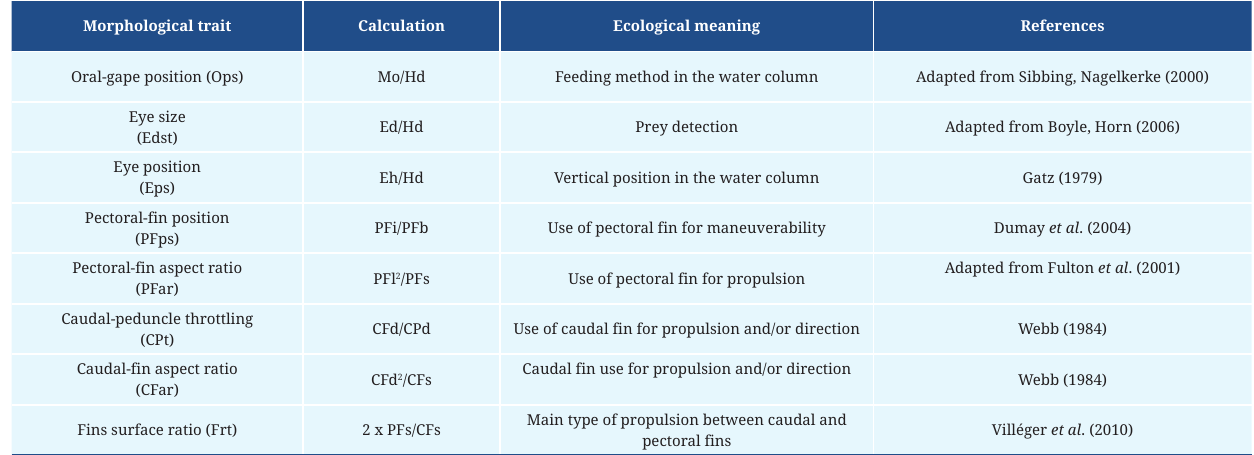
TABLE 1 | List of the eight ecomorphological traits used to functionally characterize fish species from the Carioca Lake, Middle Rio Doce basin, state of Minas Gerais, southeastern